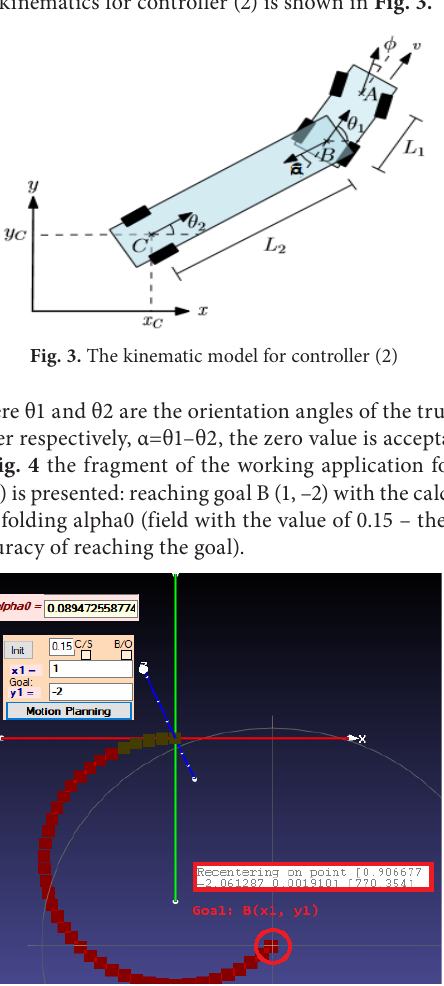
Fig. 4. Reaching the goal (controller (1)) For (2): θ1 (0), θ2 (0) are the initial orientation angles of the truck and trailer respectively (Cauchy condition), and α0 is the folding angle same as for